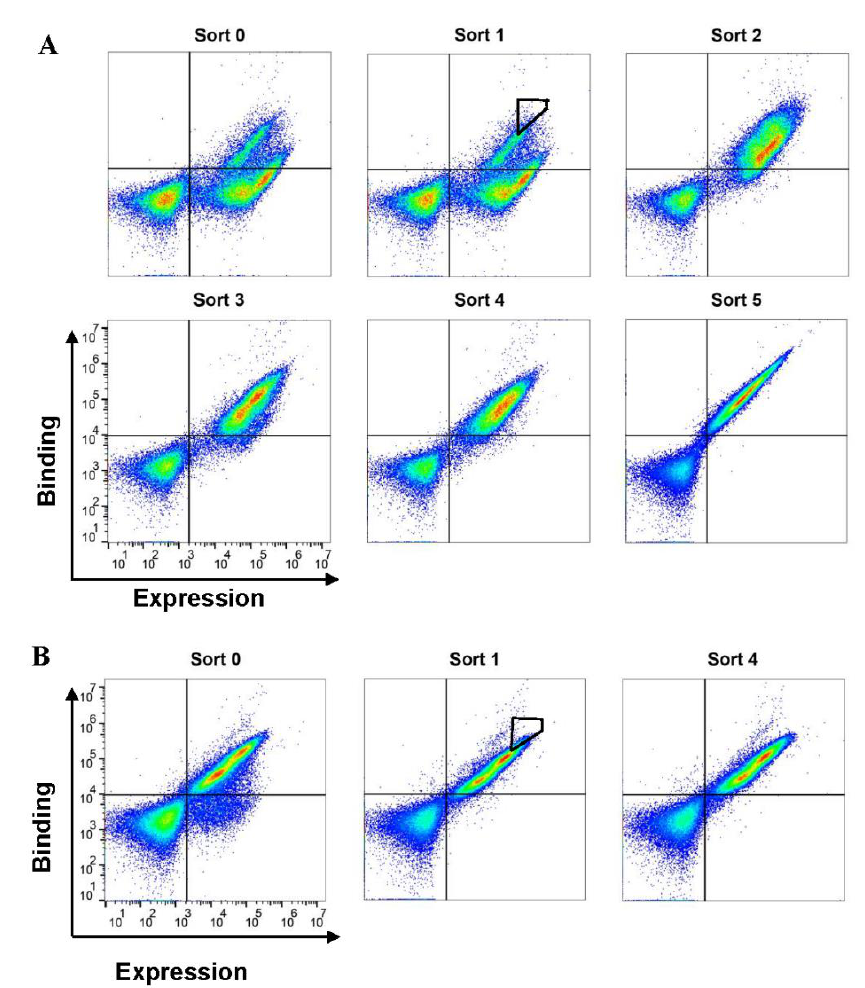
Figure 1. Flow cytometry sorting of yeast-display SCF M library enriches the c-Kit binding population. Flow cytometry analysis of our first-generation ( A ) and second-generation ( B ) libraries. Yeast-displayed SCF was labeled with anti-c-myc antibody and secondary PE-conjugated antibodies ( x -axis). Soluble c-Kit (added at 1 nM for analysis) was labeled with FITC ( y -axis). Cells having variants with the highest affinities were sorted using the gates shown only for sort #1 in both panels for purposes of the illustration; the same gate was applied to all sorts.